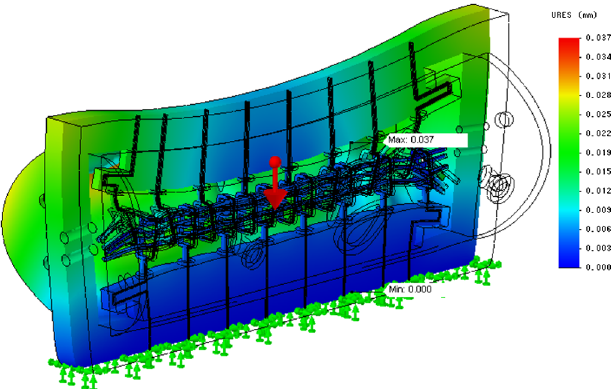
FIG. 10. Displacement of the linac by the heat stress. The room temperature is 25 (cid:4)